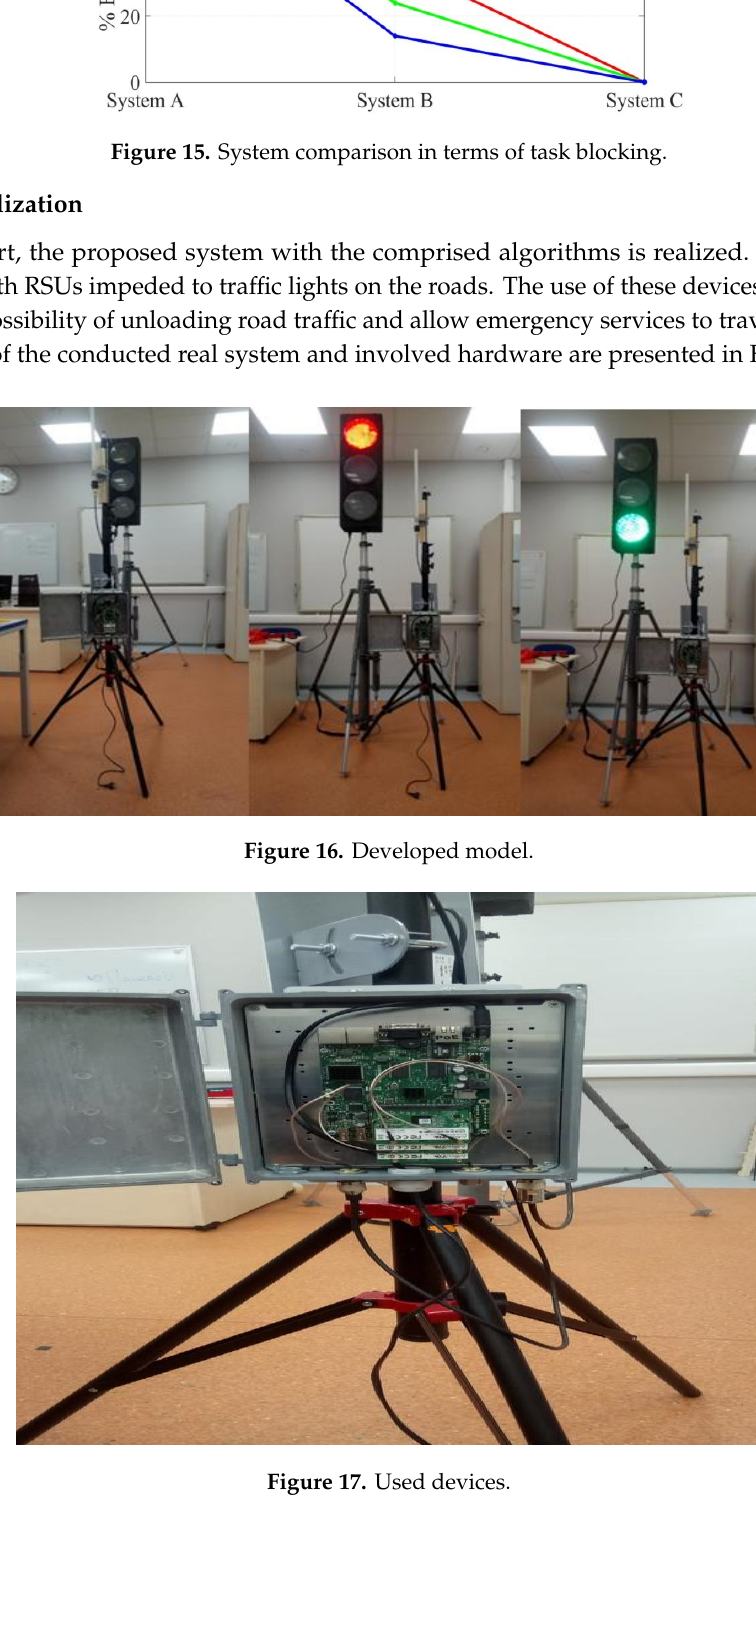
Table 8. Characteristics of the board RouterBOARD 435G.